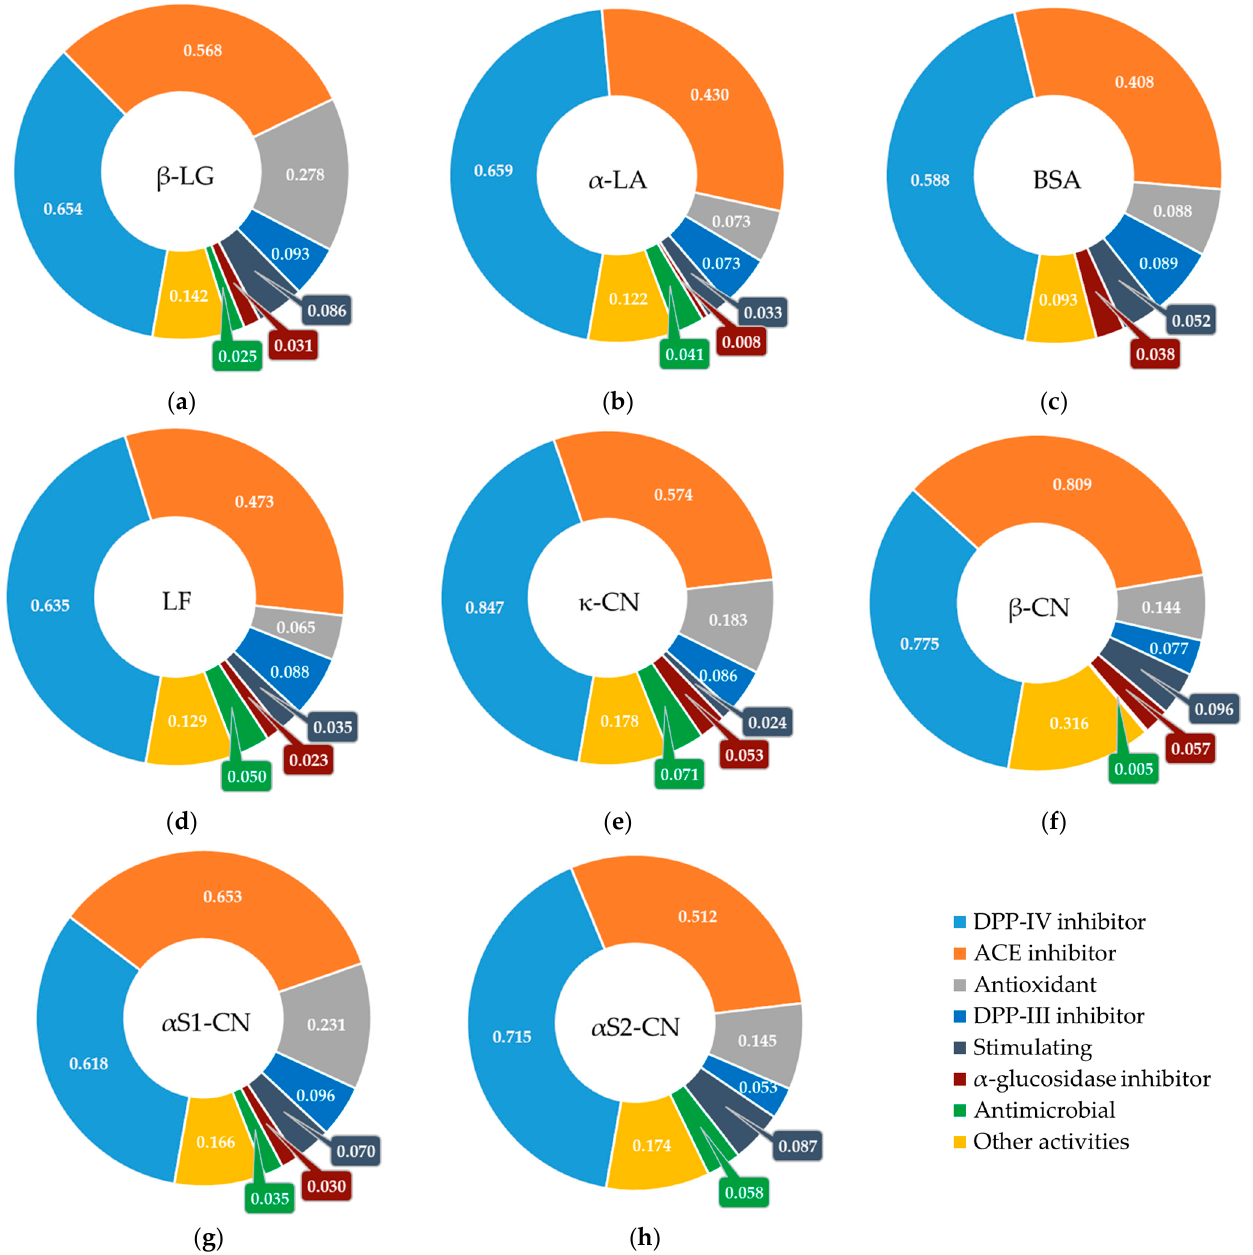
Figure 2. Frequency of bioactive fragments (A) in major whey proteins: ( a ) β -LG, ( b ) α -LA, ( c ) BSA, ( d ) LF, ( e ) κ -CN, ( f ) β -CN, ( g ) α S1-CN, ( h ) α S2-CN.